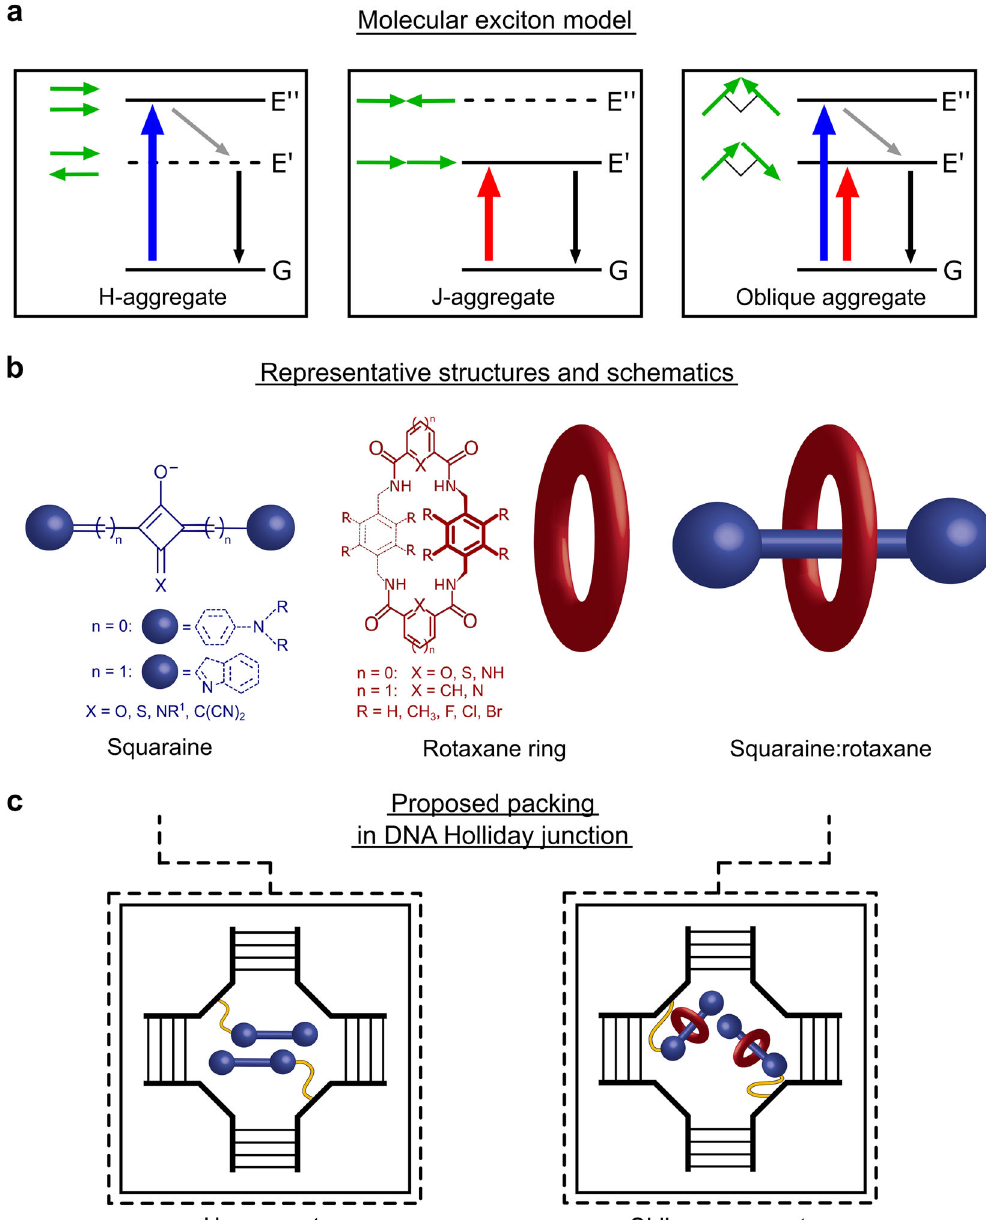
Fig. 1 Electronic structure of dimer aggregates, dye structures and schematics, and proposed packing arrangements for SQ and SR dimers templated in a DNA Holliday junction. a Energy-level diagrams for an excitonically coupled dimer, where G , E ’ , and E ” denote ground, low-lying, and high-lying excitonic states, respectively. Solid and dashed horizontal lines indicate optically accessible and inaccessible states, respectively. Adjacent to each state is a schematic of the associated dye transition dipole moment orientations. Colored, gray, and black arrows indicate optical absorption transitions, non-radiative transitions, and transitions to the ground state, respectively. b Representative structures for an SQ dye, a rotaxane ring, and an SR composite molecule. The exact chemical structures of the SQ dye and SR composite molecule are proprietary. The SQ structure (left) can be aniline-based, where six-membered rings are bound to the central squarate moiety, or it can incorporate substituents such as indolenines, where a fi ve-membered ring is conjugated with the central squarate moiety via a methine bridge. The rotaxane ring (middle) forms hydrogen bonds with the squarate moiety via its amide groups. The rotaxane ring is visualized as a red toroid shape. The SR (right) represents a composite molecule combining the SQ dye and a rotaxane ring. Both SQ and SR dyes are tethered to the DNA backbone via an amide bond between the dye and a non-nucleosidic serinol linker (Supplementary Note 1). c Proposed packing for dimers of SQs and SRs templated using a four-armed DNA Holliday junction. Dashed boxes separately highlight the H-aggregate packing proposed for the SQ dimer and the oblique aggregate packing proposed for the SR dimer. Note that the schematic is primarily intended to depict the proposed aggregate packing arrangements, not the conformation of the speci fi c DNA Holliday